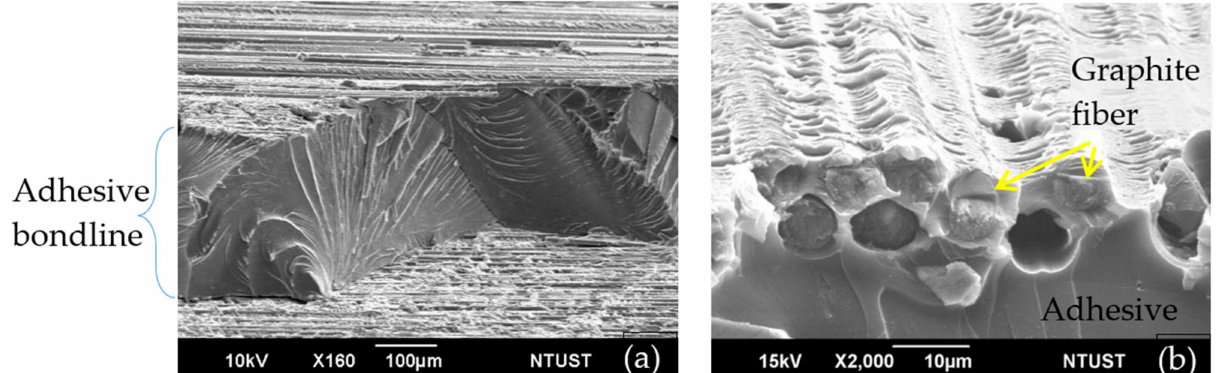
Figure 6. Scanning electron micrograph of a typical fractured joint. ( a ) Brittle cohesive fracture of adhesive; ( b ) intralamina failure of the adherend with plastic deformation markings in the resin.